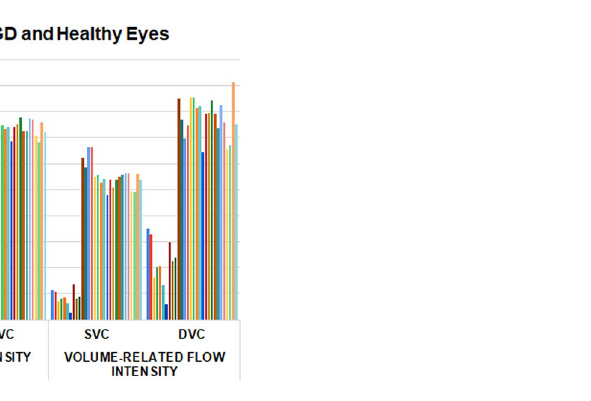
Figure 7. Functional OCTA analysis in STGD and healthy